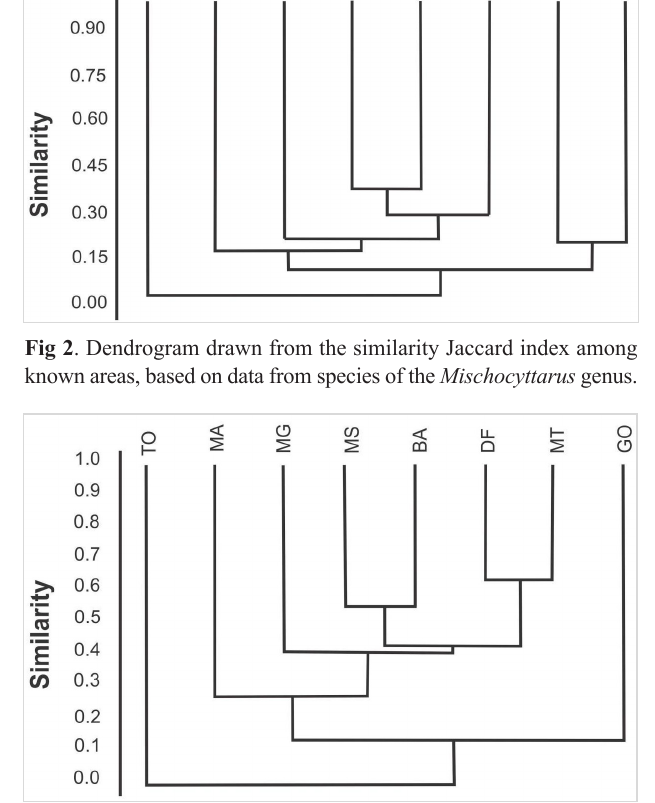
Fig 3 . Dendrogram drawn from the similarity Jaccard index among known areas, based on data from species of the genus Polistes .